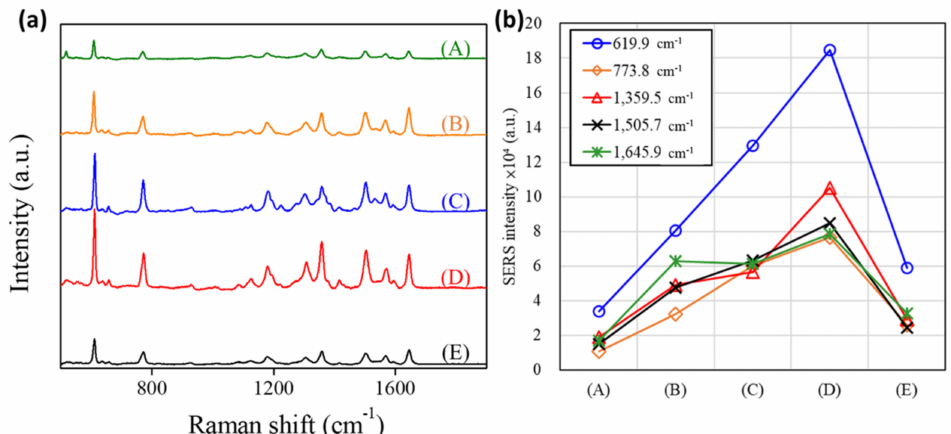
Figure 8. ( a ) Raman spectra of aqueous solutions of R6G molecules (10 − 6 M) on various Au@Ag − DNFs/Si substrates with the following ratios: (A) 250/0, (B) 190/60, (C) 125/125, (D) 60/190, and (E) 0/250 with an acquisition time of 0.5 s each. ( b ) R6G SERS intensity peaks for various samples. The wavelength of incident light is 532 nm with a power of 0.1 mW focusing in a 700 nm spot-width while Raman scattering signal accumulation time of 0.5 s.